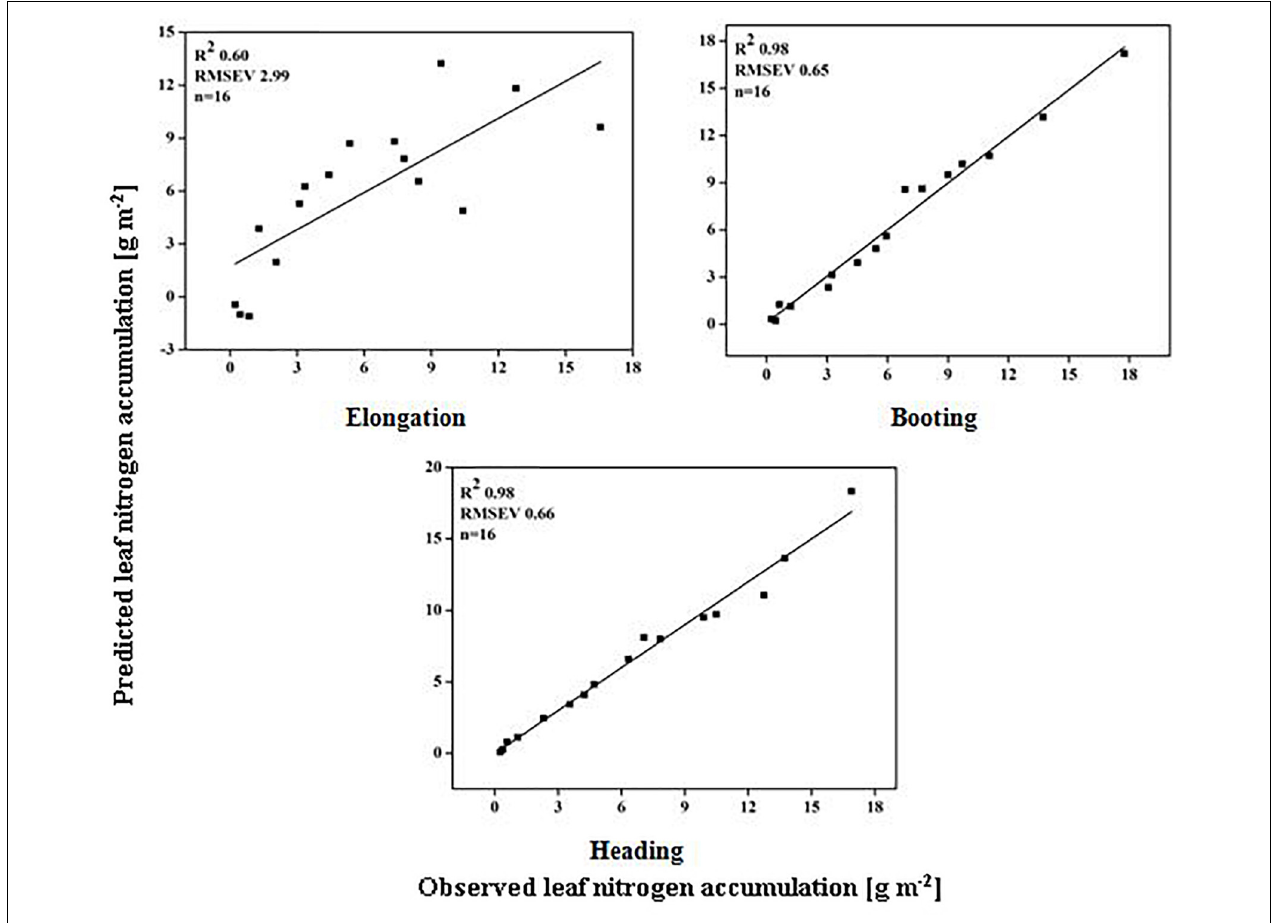
FIGURE 7 | Relationship between predicted and observed leaf nitrogen accumulation (g m − 2 ) over phenological stages of